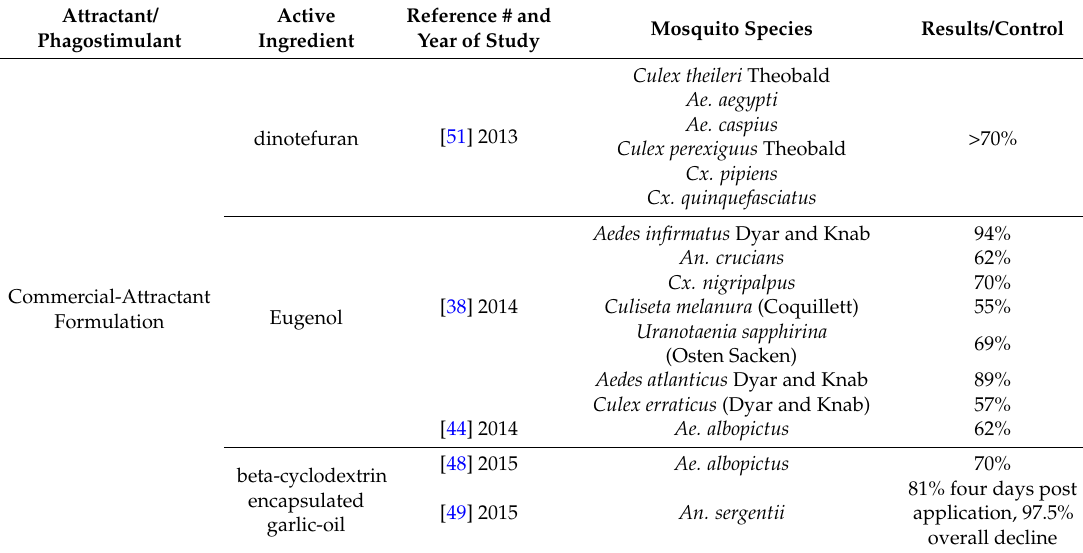
Table 3. Attractive sugar bait studies (ATSB) with commercial-attractant formulation. Data represents attractant sources and phagostimulants, references for studies with dates, and results of